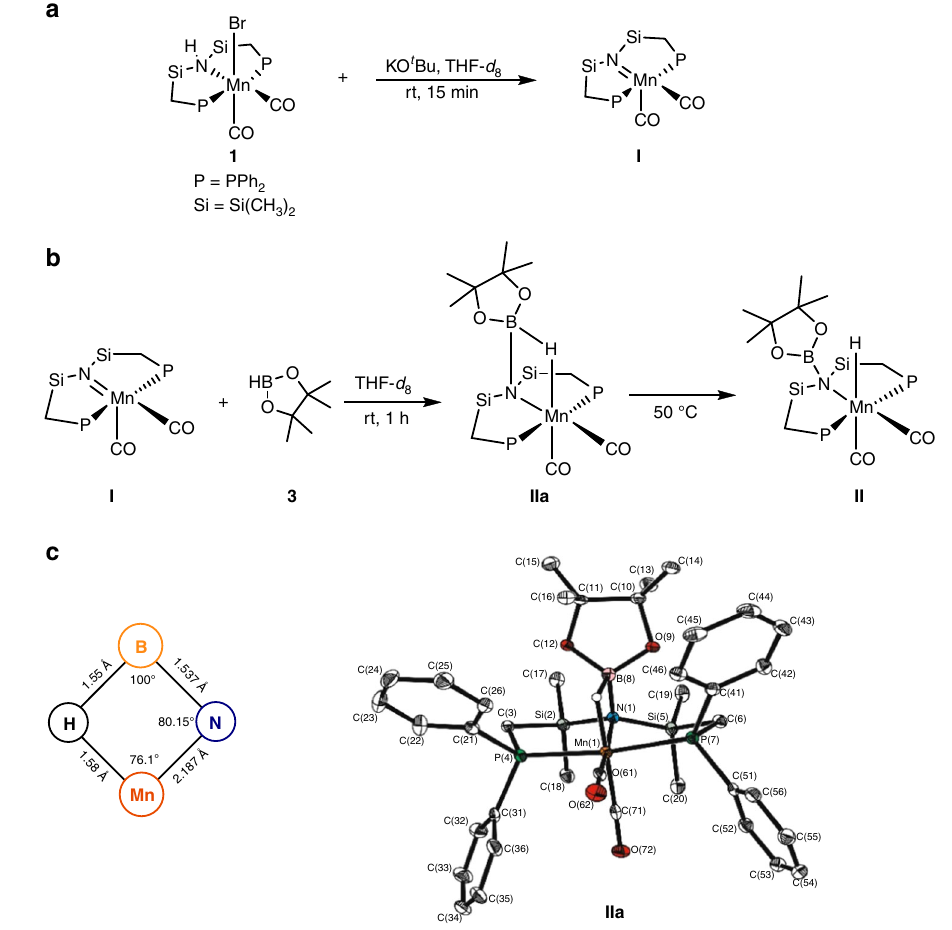
Fig. 2 Generation of potential reaction intermediates and molecular structure of IIa . Overall geometry for IIa : distorted octahedral. Selected angles and atom distances: [P(4)-Mn(1)-P(7) = 172.38°], [C(61)-Mn(1)-C(71) = 86.73°], [N(1)-Mn(1)-P(4) = 88.85°], [N(1)-Mn(1)-P(7) = 88.90°], (Mn(1)-N(1) = 218.7 pm), (Mn(1)-P(4) = 226.93 pm), (Mn(1)-P(7) = 226.95 pm), (N(1)-Si(2) = 178.1 pm), (N(1)-Si(5) = 177.9